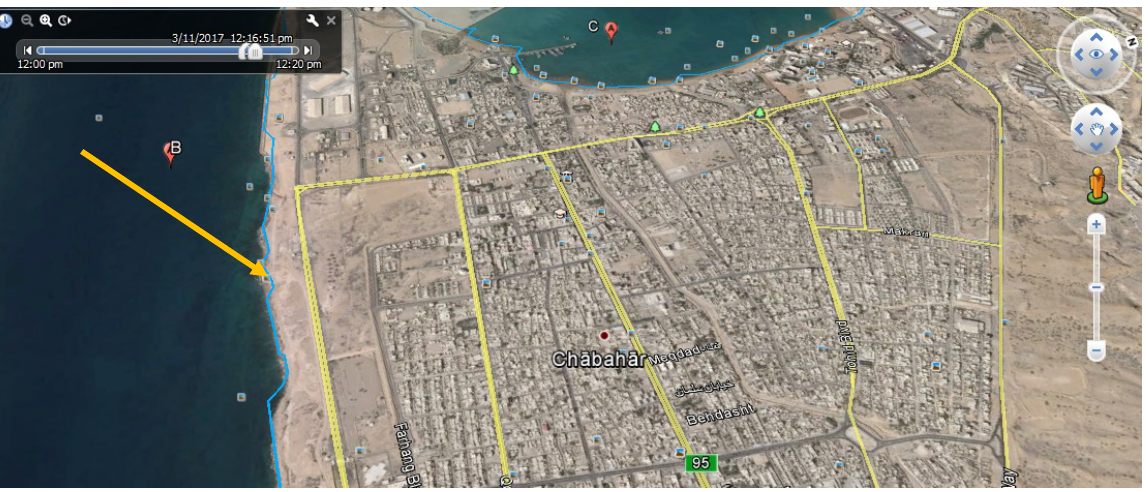
Figure 5. Flowchart of transformation of file geodatabase to KML. Using FME software. 1. Read features from the file geodatabase, 2. Format date into the KML time standard, dateTime as defined in the XML specification, 3. Sets the format attribute kml_timestamp_when (Timestamp). The transformer can also set the kml_timespan_begin and kml_timespan_end (Timespan), 4. Sets the icon for the output features, as well as the line width and colour, 5. The source data is not coordinate system aware. The data is tagged as LL83 (google earth coordinate system) so that it can be displayed in Google Earth. The blue line in Figure 6. Shows coastal line during tsunami represents the coastal line affect the tsunami after 18 minutes simulation with 15 meters resolutions. According to this and 20 seconds. The time bar will move slowly along the scale from the minimum to the maximum value, and features within the main display be turned on and off according to whether their after this time tsunami wave passed the dry land. Figure 7, time stamp (or time span) falls within the current date range.